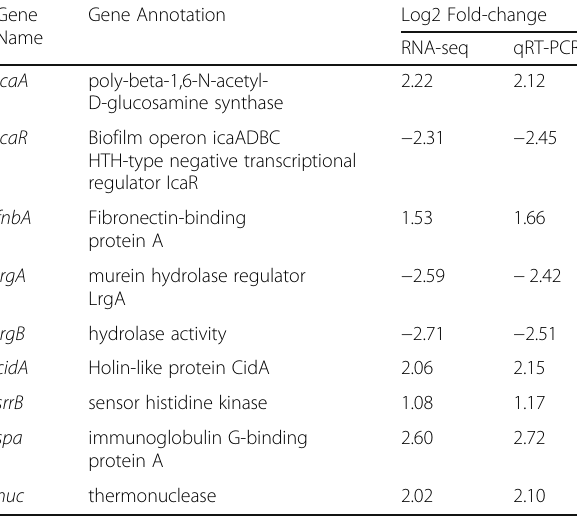
Table 4 The fold-change determined by RNA-seq and qRT-PCR of selected